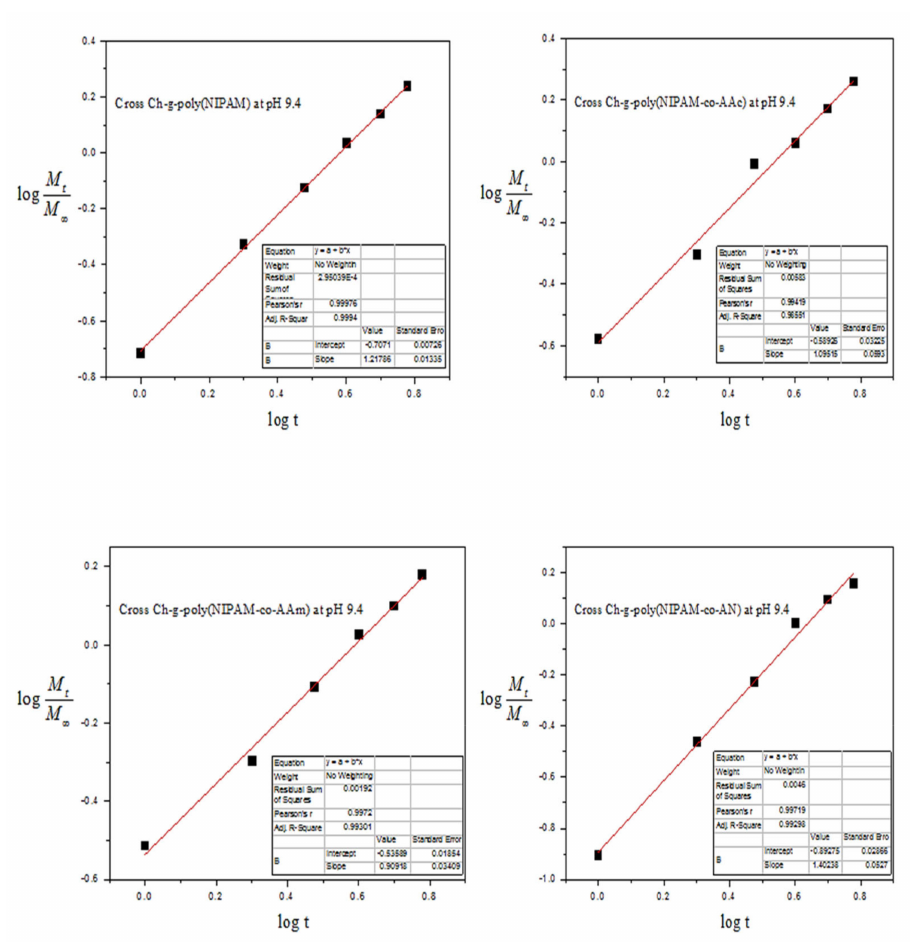
Figure 12. Drug release kinetics of Crosslink-Chit- g -polymer (NIPAAM), Crosslink-Chit- g -polymer (NIPAAM- co -AA), Crosslink-Chit- g -polymer (NIPAAM- co -AAm) and Crosslink-Chit- g -polymer (NIPAAM- co -AN) at pH